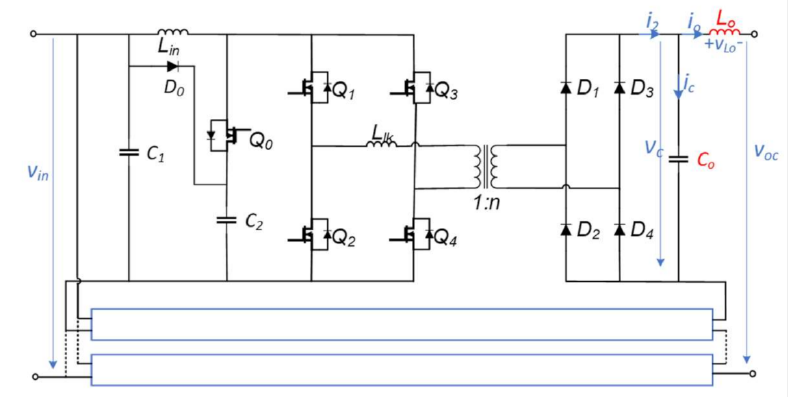
Figure 6. Converter topology with LC